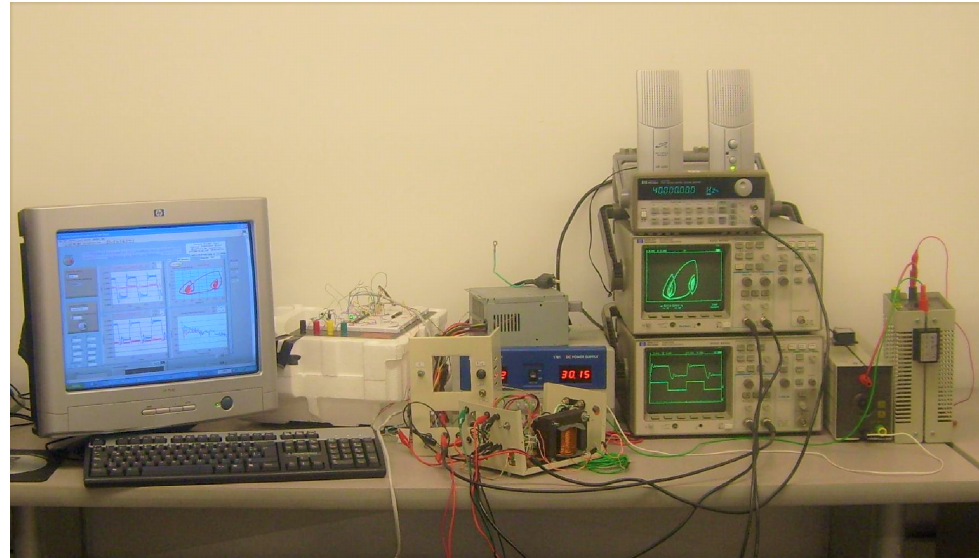
Figure 18. Test bench and experimental prototype for the Buck Converter with Hysteresis Control.